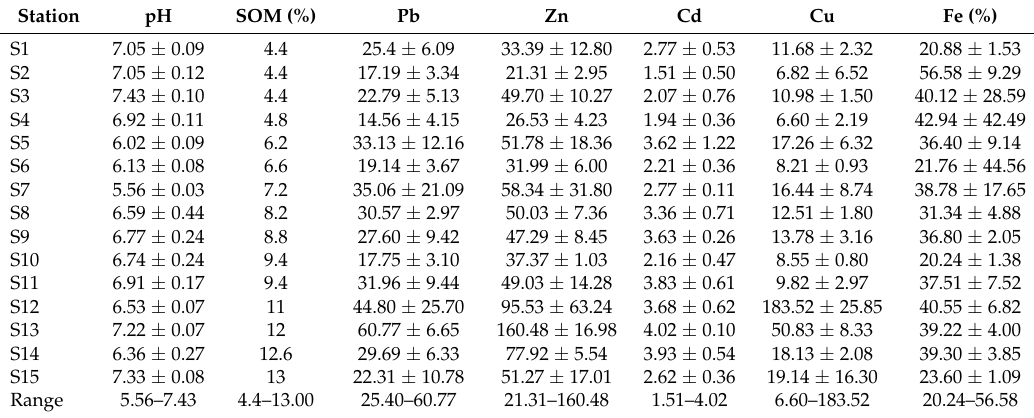
Table 1. Heavy metal concentrations ( µ g/g) in the surface sediments of Perak River ( n =